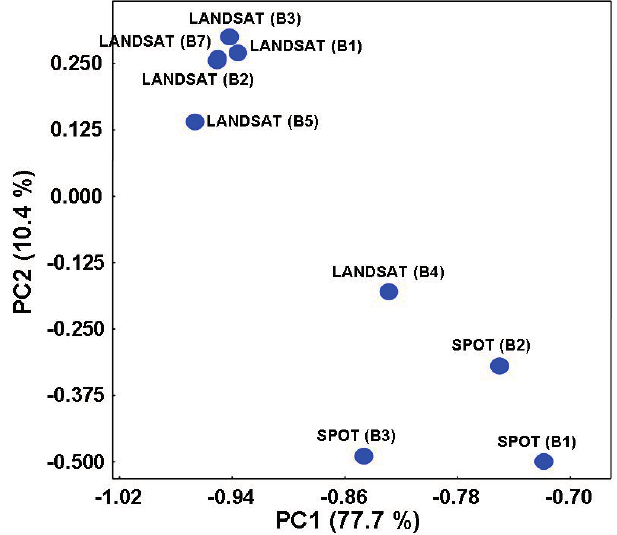
Figure 10. Loadings plot representing the distribution of the satellite spectral bands (variables) in the reduced bi-dimensional principal factor space. PC1 and PC2 are the first and the second principal component,